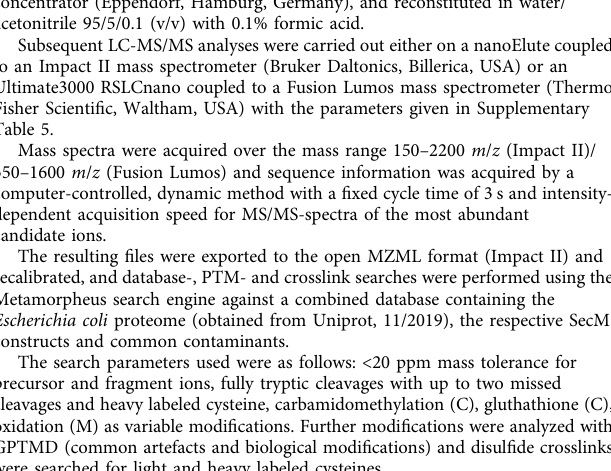
Table 5. Mass spectra were acquired over the mass range 150 – 2200 m / z (Impact II)/ 350 – 1600 m / z (Fusion Lumos) and sequence information was acquired by a computer-controlled, dynamic method with a fi xed cycle time of 3 s and intensity- dependent acquisition speed for MS/MS-spectra of the most abundant candidate ions. The resulting fi les were exported to the open MZML format (Impact II) and recalibrated, and database-, PTM- and crosslink searches were performed using the